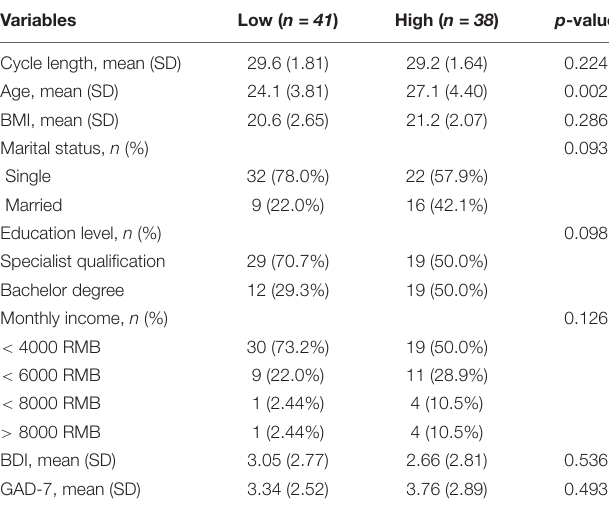
TABLE 1 | Demographics and work characteristics of the sample.